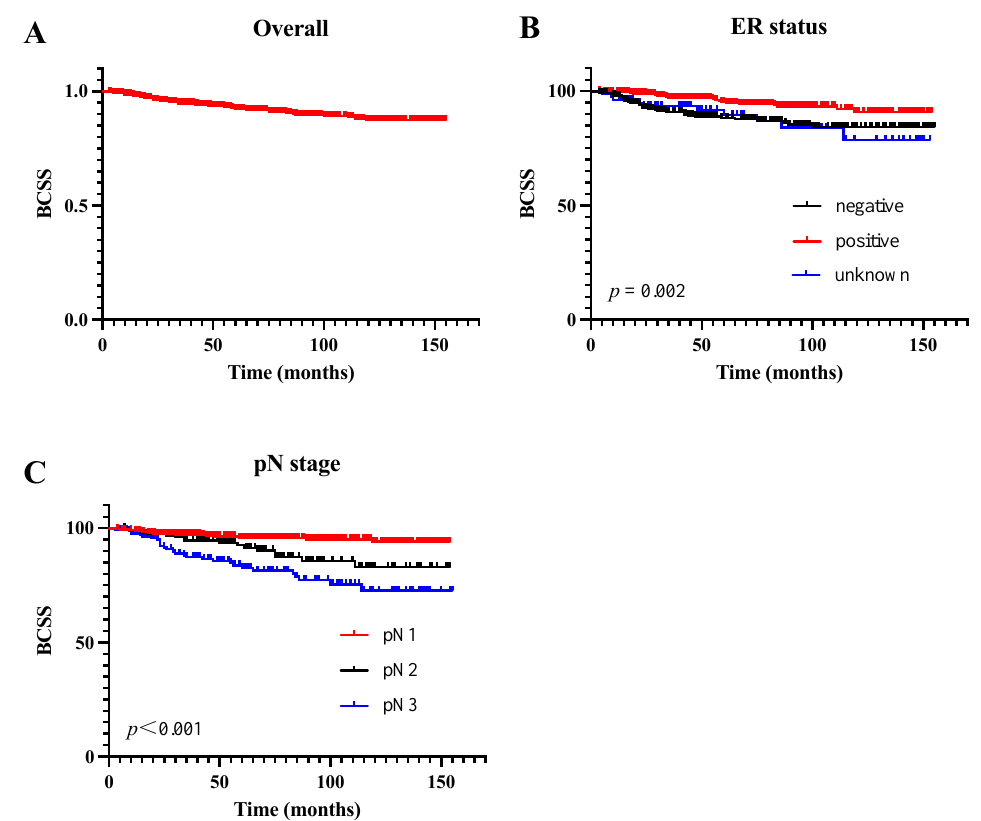
Figure 2. Survival curves of the cohort and the subgroups. ( A ) Kaplan–Meier curve of the cohort;